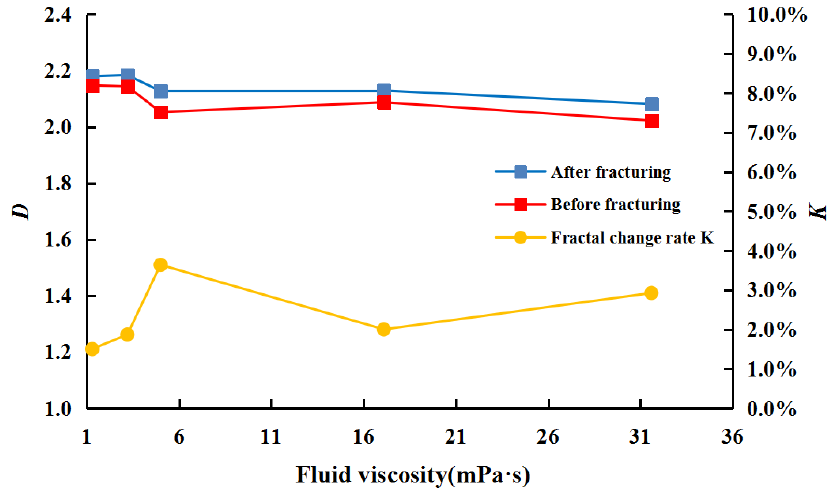
Figure 11. Relationship between the fractal dimension, fractal change K, and fluid viscosity. The distribution of fractal dimension ( D NH ) under different fluid viscosities